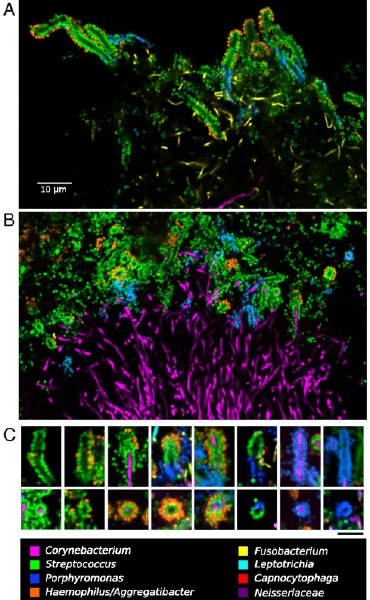
Figure 6. Dense corncob structures in supragingival plaque. ( A ) The central filament lacked hybridization in whole-mount preparation. ( B ) The central filament was well visualized in methacrylate- embedded and sectioned preparations. ( C ) Representative images of types of corncobs found. Bar indicates 5 µ m in ( C ). Reprinted with the publisher’s